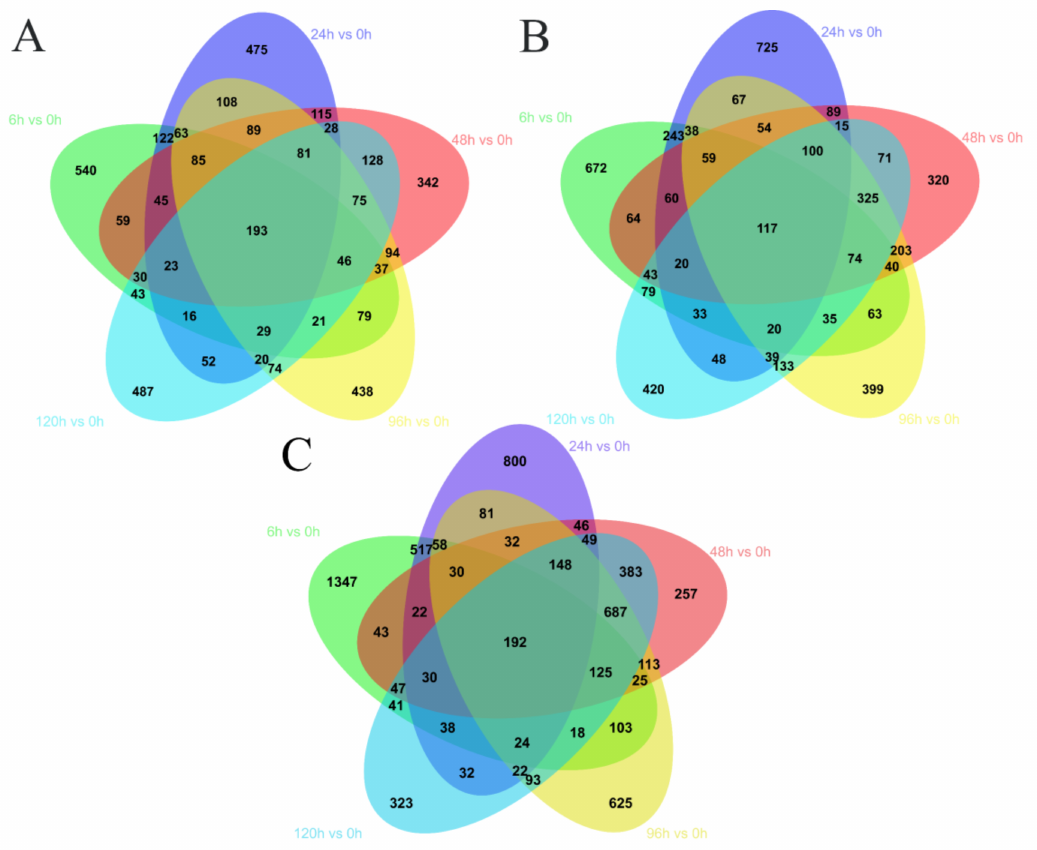
Figure 2. Venn diagrams of differentially expressed genes in the blood ( A ), liver ( B ), and gills ( C ) of L. crocea under hypoxia and reoxygenation conditions. All samples were compared to the 0 h control for the respective tissue